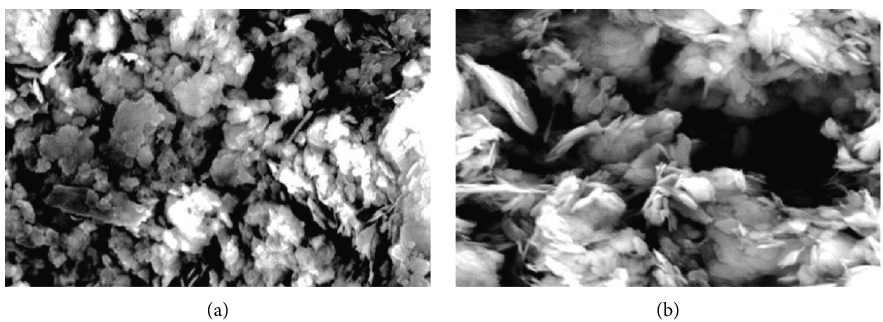
Figure 14: SEM photographs of uniaxial soil pressure tests, 10% lime and 4% sodium